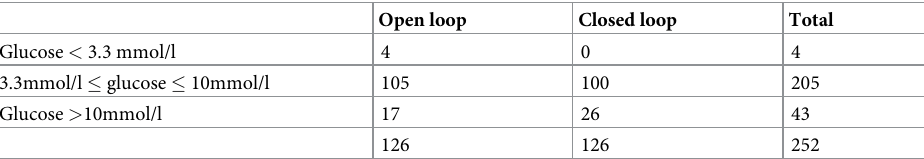
Table 3. Hyper- and hypoglycemic events during the night in open and closed